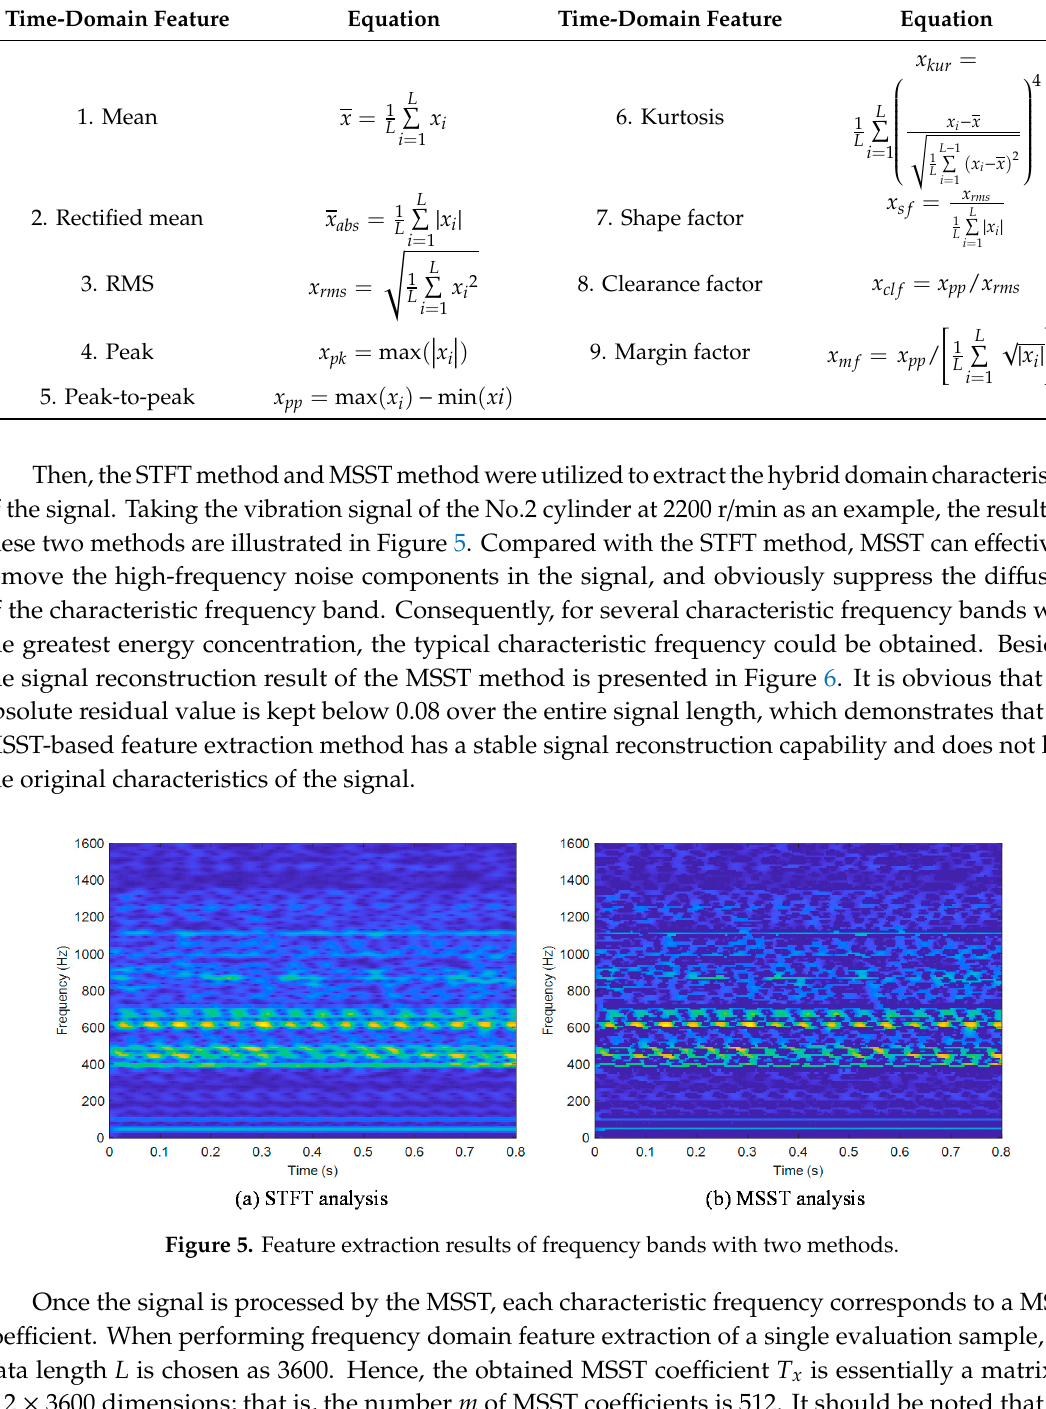
Table 3. Definition of utilized statistical features in the time-domain for the vibration signal. Time-Domain Feature Equation Time-Domain Feature